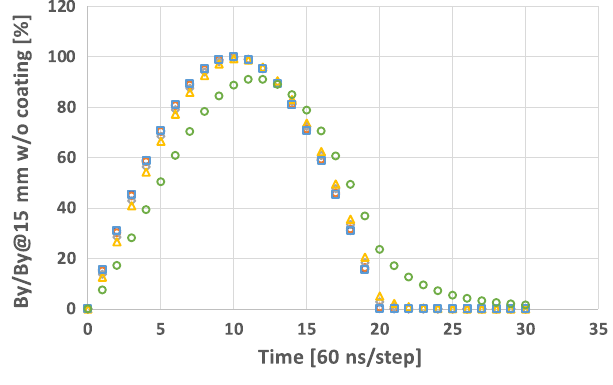
FIG. 14. Estimation by G dfid L of the beam heat generation for the pattern-coating shape of an implementation